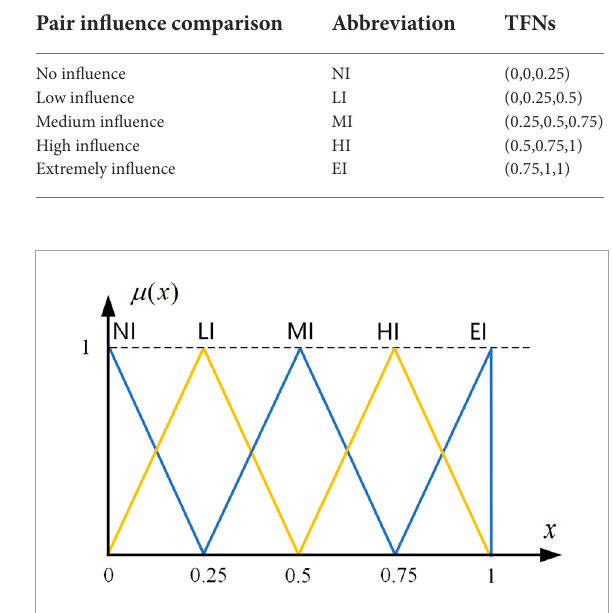
FIGURE 5 Membership functions of TFNs of linguistic variables in Table 3